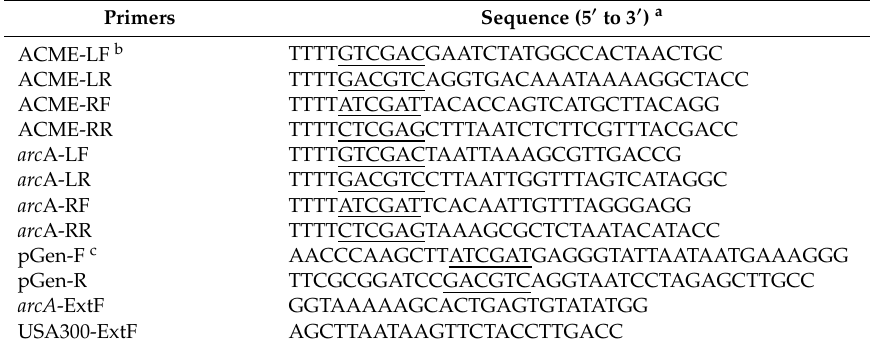
Table 1. Primers for construction of USA300-2406 ∆ arc A and ∆ ACME mutants. Primers